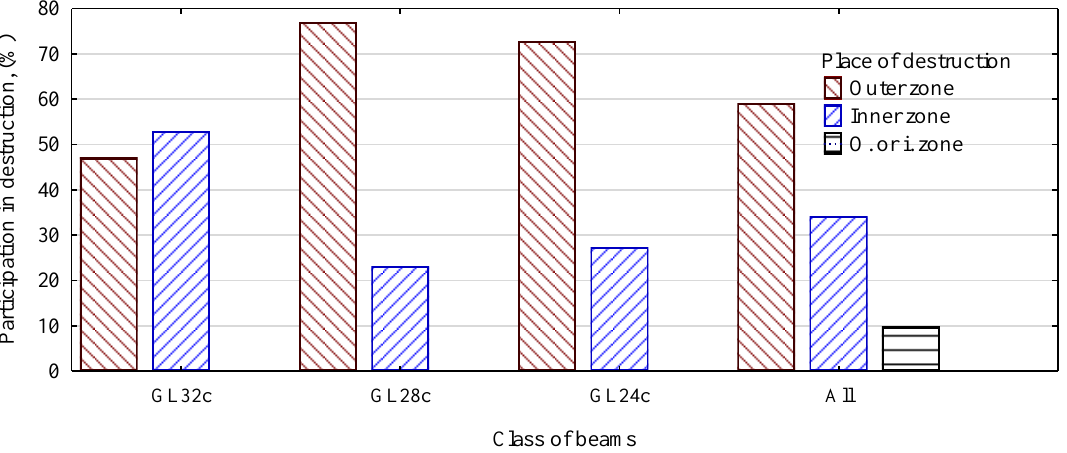
Figure 8. Impact of the point of destruction for various beam grades.